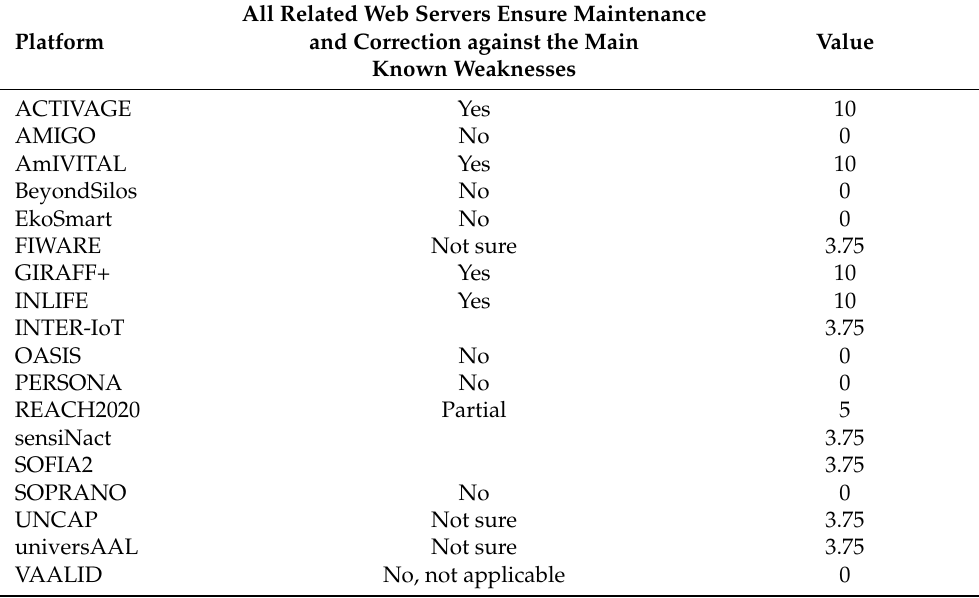
Table 1. An example of transforming the text description of platforms into proper values for further analysis. “Yes” is transformed into 10, “No” to 0, “Partial” to 5, and the missing values to the mean of the existing values in the column, which is